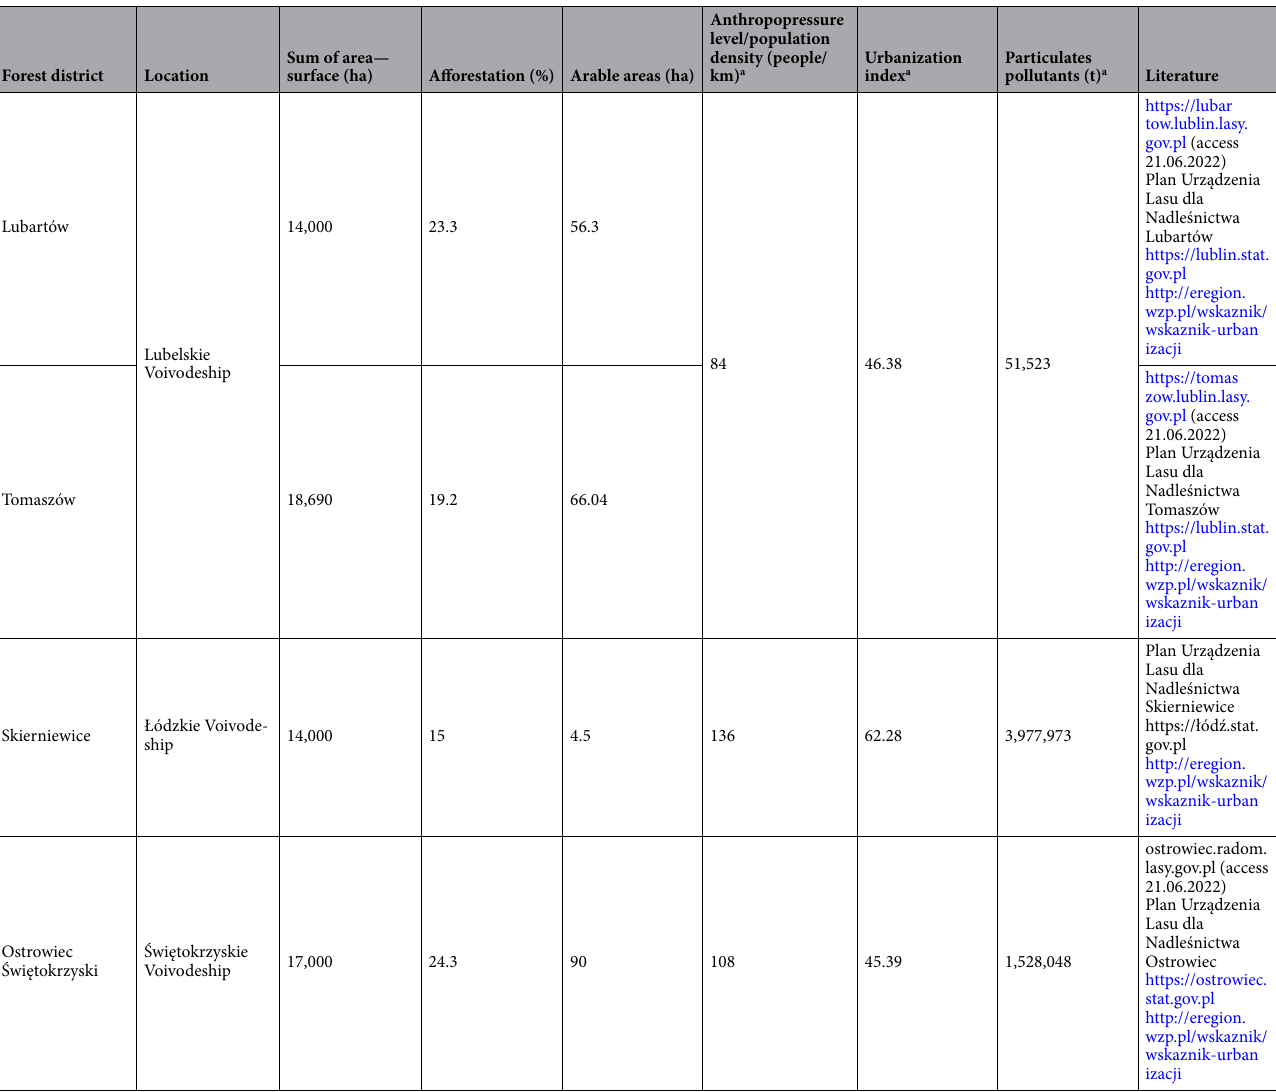
Table 1. Characteristics of the researched areas a . a Data obtained for